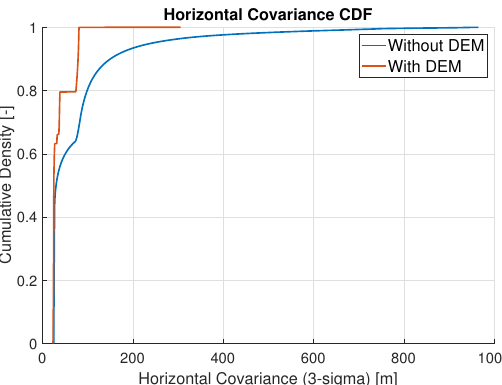
Figure 12. Cumulative density function of the 3-sigma horizontal covariance (considering the time domain).